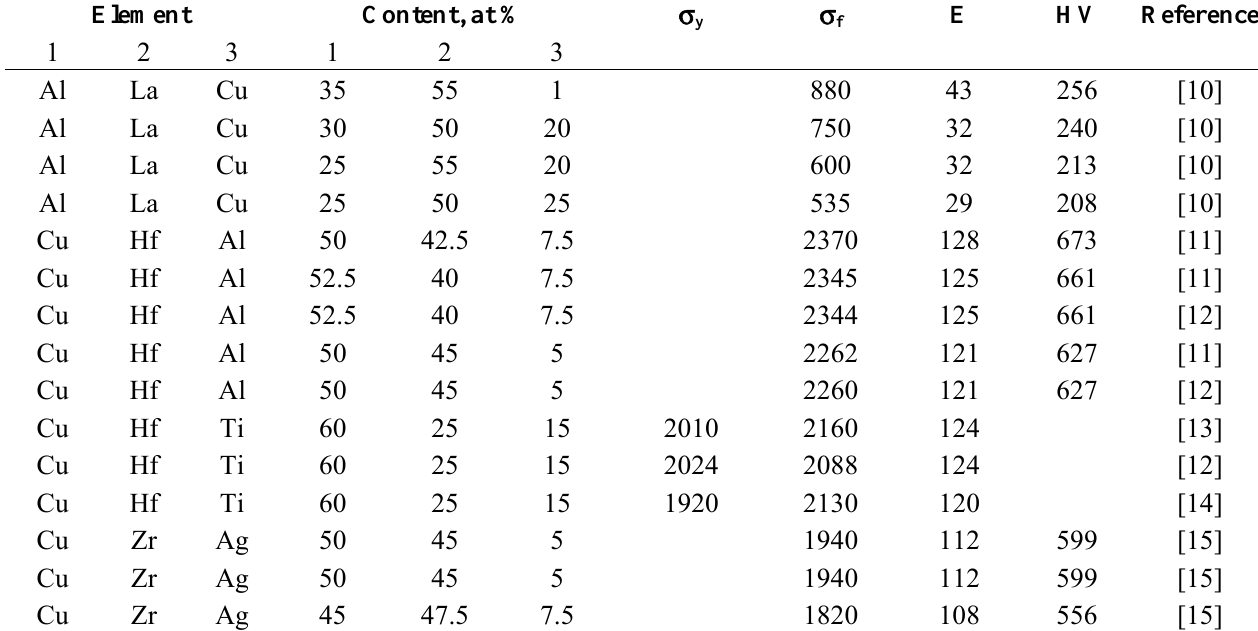
Table 1. Composition and mechanical properties of ternary bulk glassy